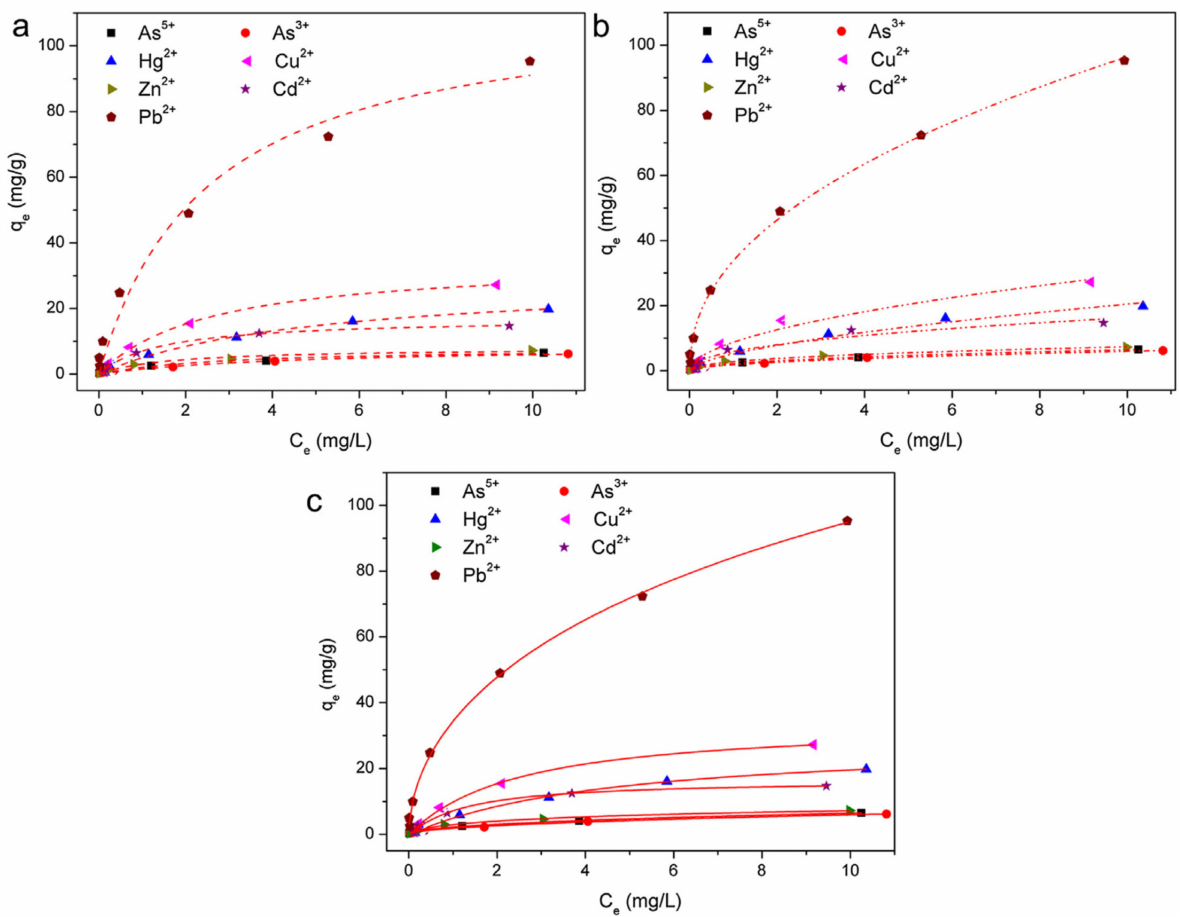
Figure 8. Adsorption isotherm for metal ions adsorption by cyshtcc-Fe 3 O 4 , ( a ): Langmuir fit; ( b ): Freundlich fit; ( c ): Sips fit. Reused with permission from